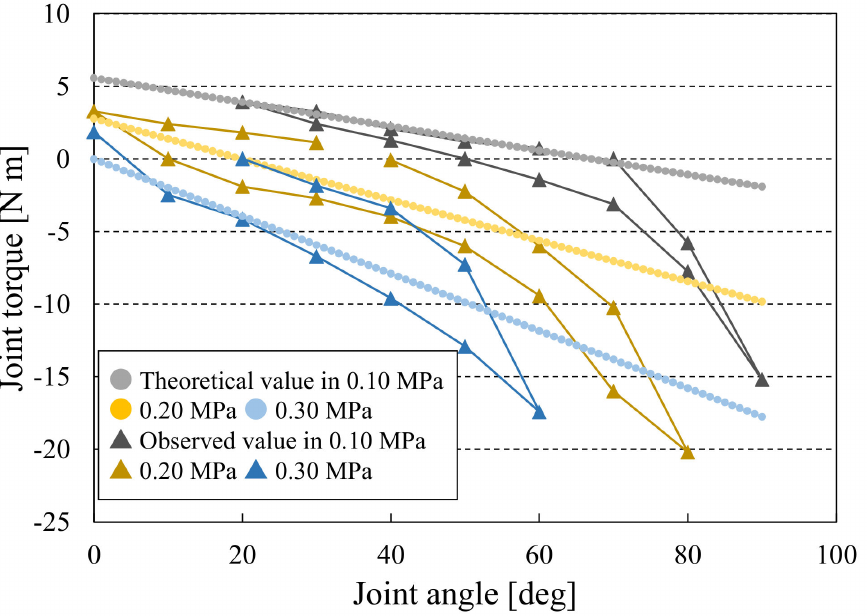
Figure 9. Relationship between the joint torque and the joint angle of theoretical and observed values [20].